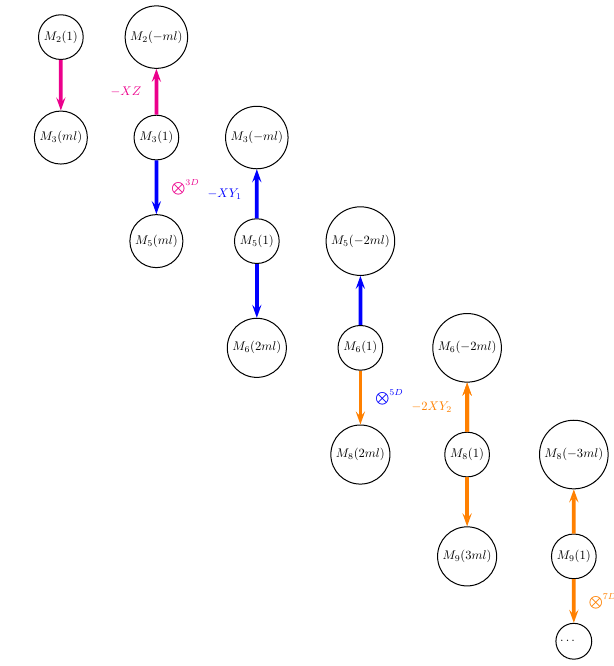
Figure 1. A schematic diagram of an extended feedback loop which consists of the downscaling and upscaling processes associated with J(M 1 , M j ) , j = 2, 3, 5, 6, 8 or 9. For a given M j mode, J(M 1 , M j ) may lead to a downscaling process, as indicated by a down- ward arrow, and/or an upscaling process, as indicated by an upward arrow. The nonlinear feedback loop in the 3DLM and its extension within the 5DLM are shown with pink and blue arrows, respectively (e.g., Shen, 2014a). Further extension of the nonlinear feedback loop within the 7DLM is shown with orange arrows. A number in parentheses is the coefficient of the specific mode. The “ M 3 (ml) ” in the leftmost column represents the fact that the M 3 mode with a coefficient of “ml” is generated or influenced by a downscaling pro- cess from J(M 1 , M 2 ) . The terms − XZ , − XY 1 , and − 2 XY 2 , which appear in Eqs. (12), (13), and (15), are associated with the upscaling process of the J(M 1 , M 3 ) , J(M 1 , M 5 ) , and J(M 1 , M 8 ) that are in- dicated by the pink, blue, and orange upward arrows, respectively. ⊗ 3-D , ⊗ 5-D and ⊗ 7-D indicate the end of downscaling due to mode truncation in the 3DLM, 5DLM, and 7DLM,